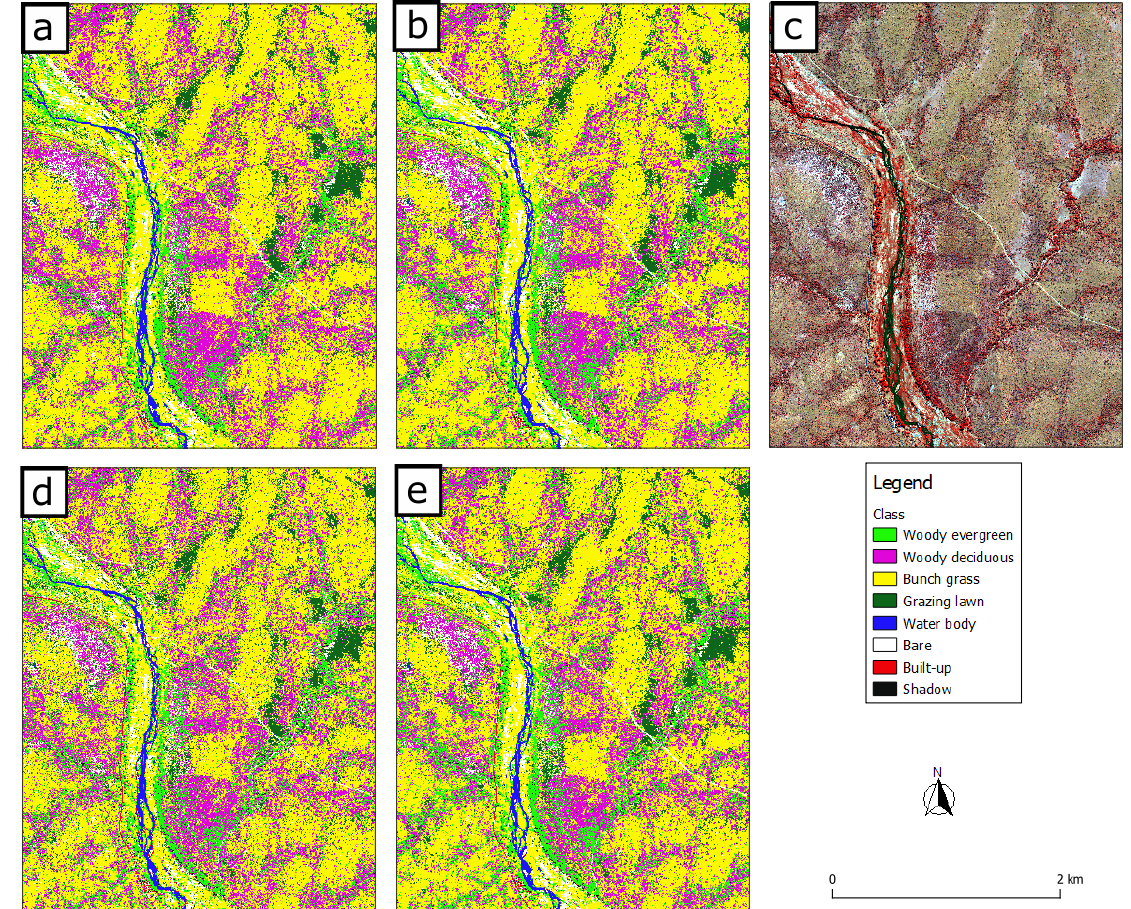
Figure 5. Land cover classification of the training region from ( a ) RF, ( b ) SVM, ( d ) CART and ( e ) MLP models. The WorldView-3 image scene (False colour: NIR1, R, G) of the training region is showed in panel ( c ). RF = Random Forest, SVM = Support Vector Machines, CART = Classification and Regression Trees and MLP = Multilayer